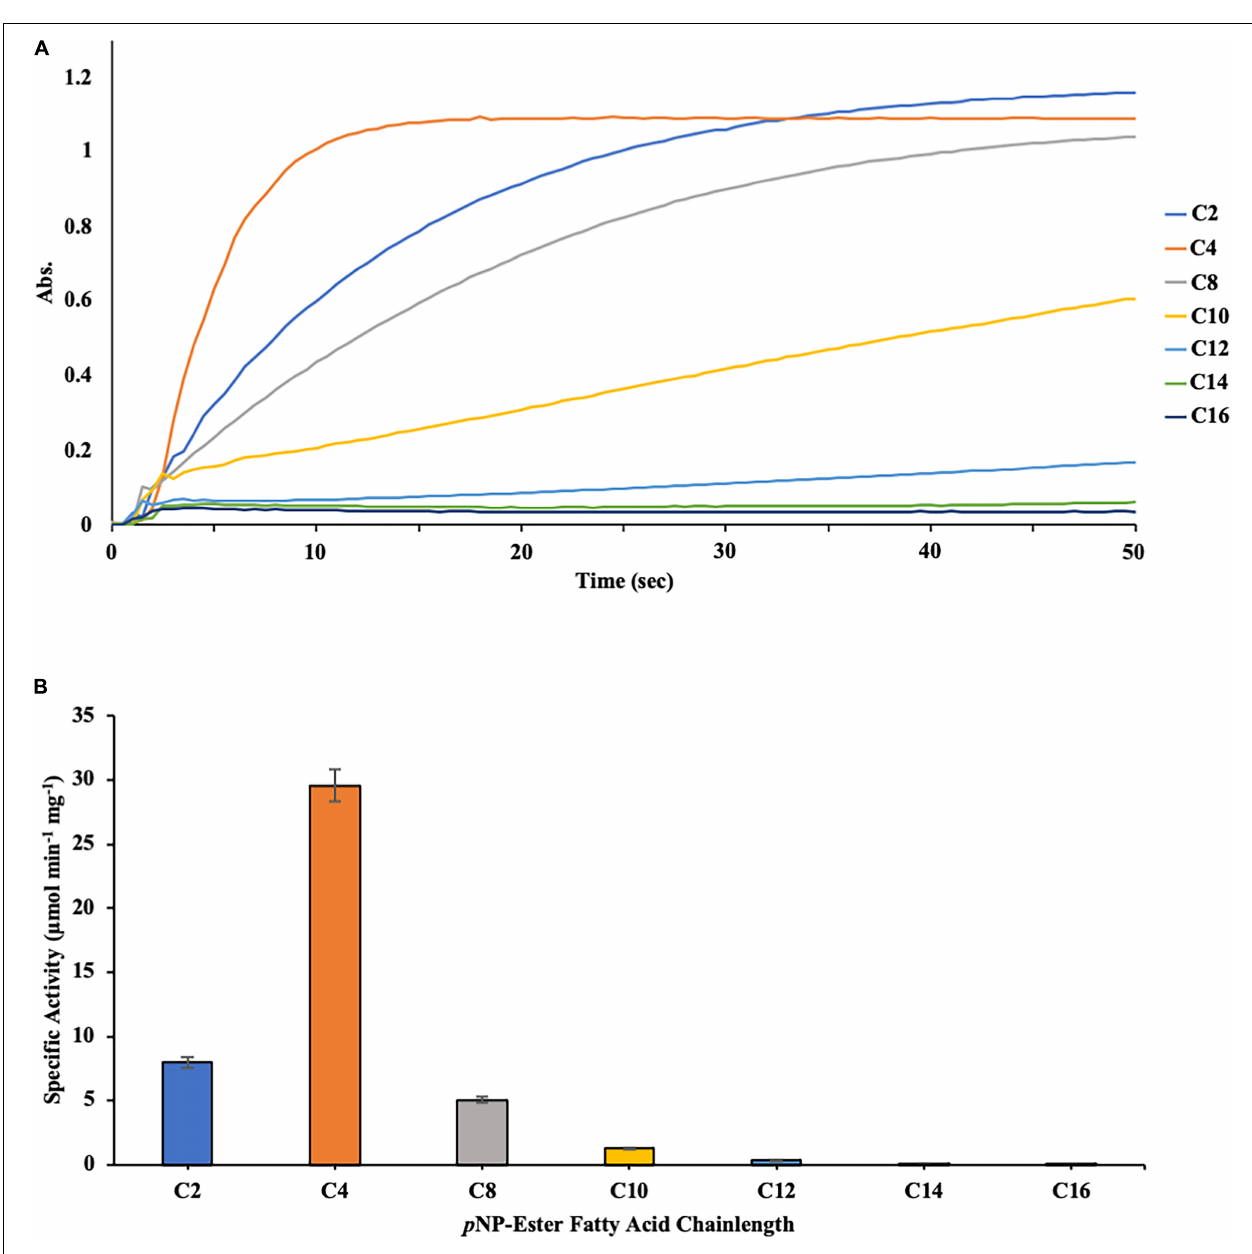
FIGURE 4 | (A) Measurement of the initial velocity of the hydrolysis of p-nitrophenyl substrates with different chain-lengths catalyzed by DS-007. Absorption was measured for 200 s at 405 nm. This data was then used to calculate DS-007’s activity. (B) Substrate specificity of DS-007 showed a preference for short-chain substrates ( ≤ C 8 ) with the maximum activity observed with p -nitrophenyl butyrate (C 4 ). Specific activity was determined from the initial velocity determined in (A) . (A) Show representative results, (B) the average and standard deviation from 3 independent experiments.